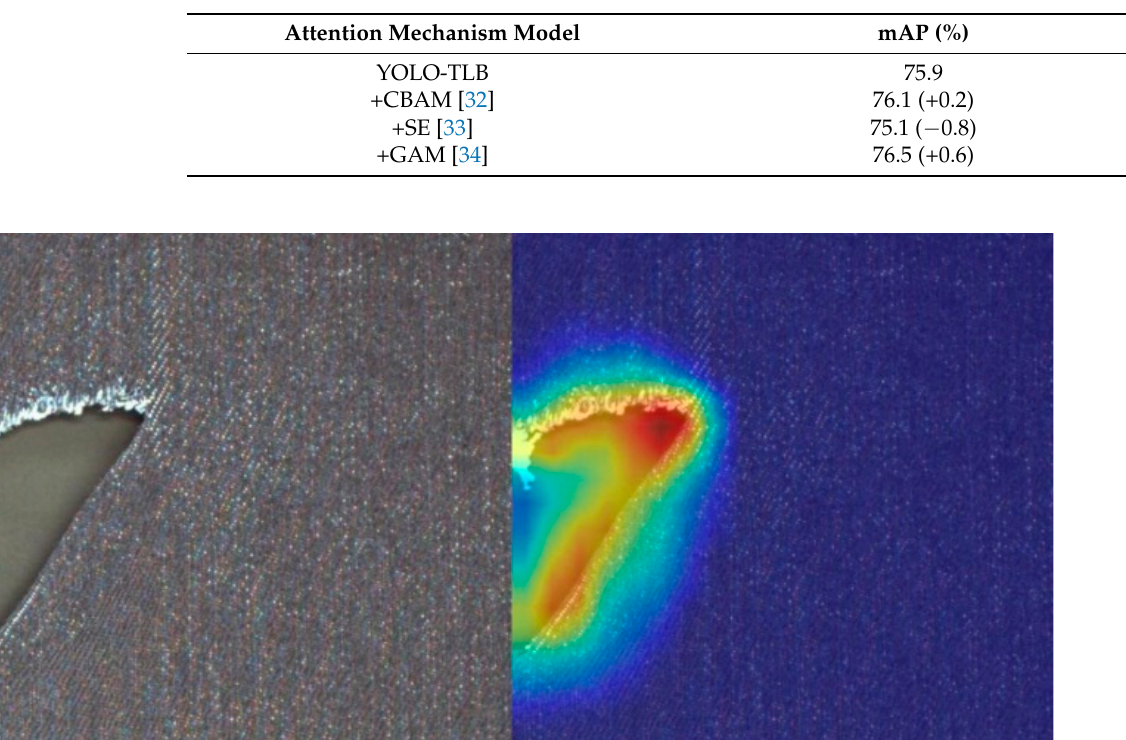
Table 5. Results of different attention mechanisms.